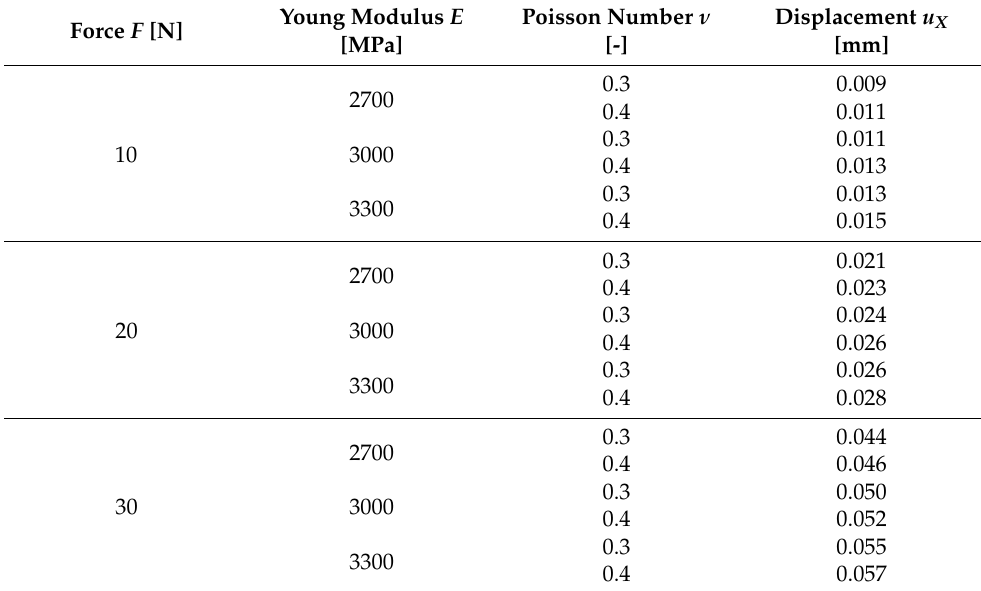
Table 2. Values of Young modulus E , the Poisson ratio ν , and displacement u X obtained from simulations for various values of the loading force F .